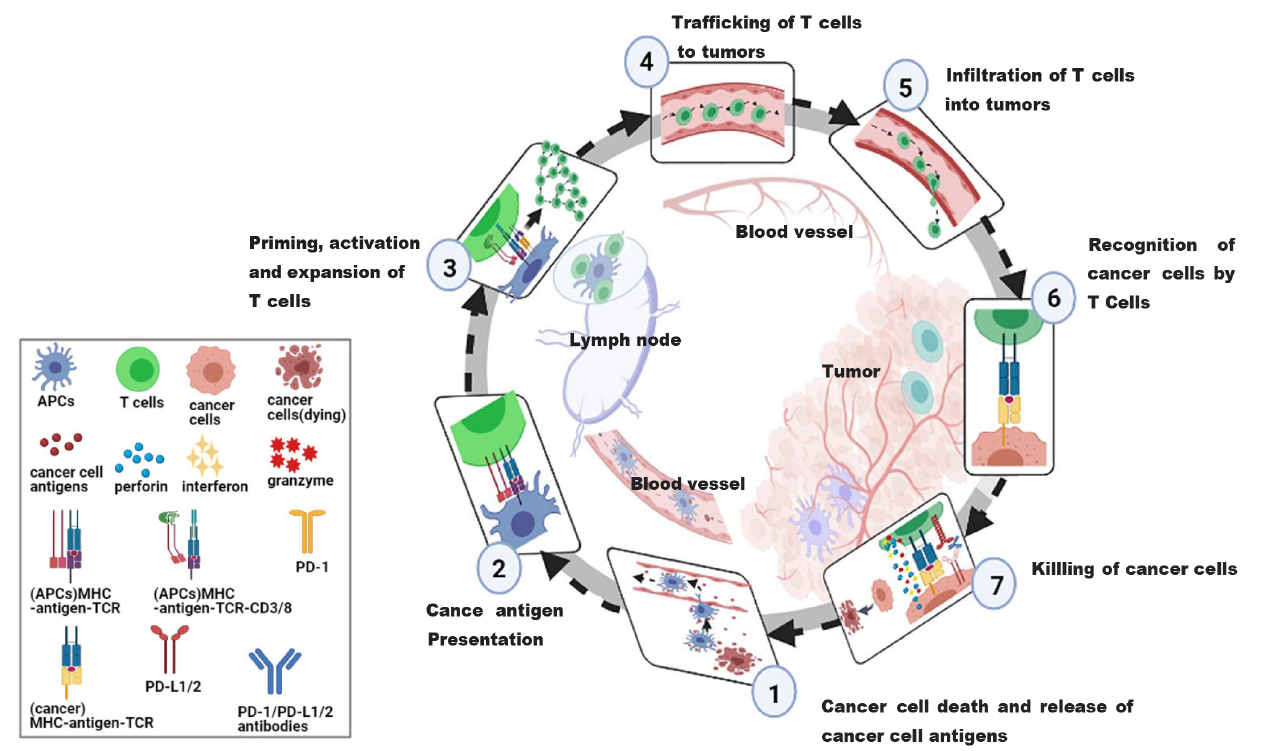
FIGURE 2 | The cancer-immunity cycle. An effective anticancer immune response is a cyclic process, theoretically, which can be divided into seven major steps, starting with the release of antigens from the cancer cell and ending with the killing of cancer cells. Importantly, these steps must be repeated to amplify and broaden T cell responses. Each step is described as above, with the primary cell types involved and the anatomic location of the activity listed. APCs, antigen presenting cells, a type of cell in the body that takes up, processes and transmits antigenic information, and induces an immune response from T and B cells; MHC, major histocompatibility complex, involved in antigen presentation and the associated immune response, divided into MHC I and MHC II; MHC I, responsible for presenting viral, tumor or parasitic antigens; MHC II, responsible for initiating the immune response in bacterial infections; TCR, T cell receptor, an antigen receptor on the surface of T cells that recognizes pMHC complex; PD-1, programmed cell death protein 1, located on the surface of T cells and primary B cells; PD-L1/2, programmed cell death 1 ligand 1/2, ligand for